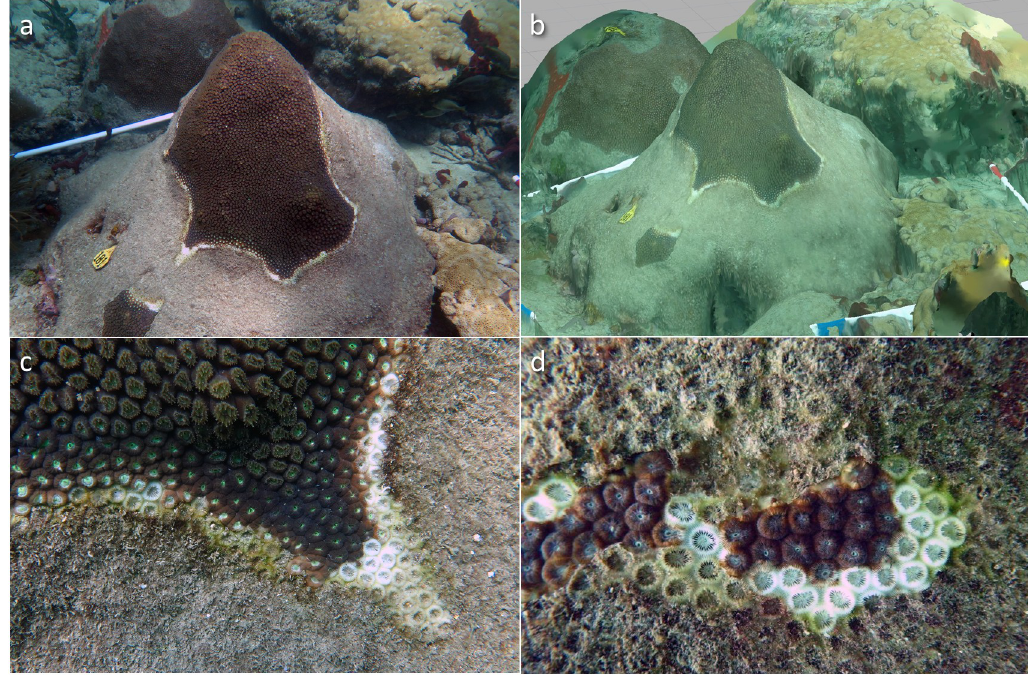
Fig 1. SCTLD lesions on a colony of Montastraea cavernosa . (a) Fate-tracked, SCTLD-infected Montastraea cavernosa with (b) rendered 3D model, (c) characteristic disease lesion, and (d) necrotic tissue.